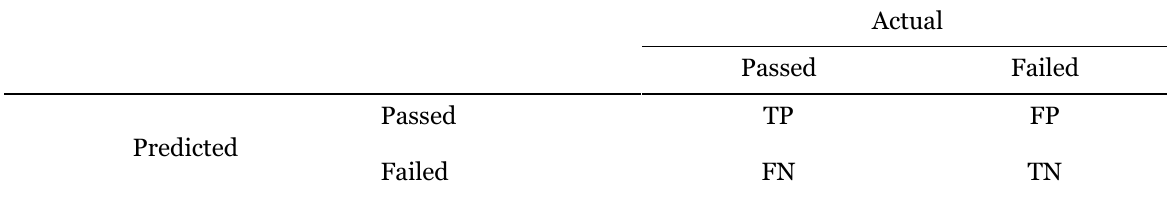
Actual Passed Failed